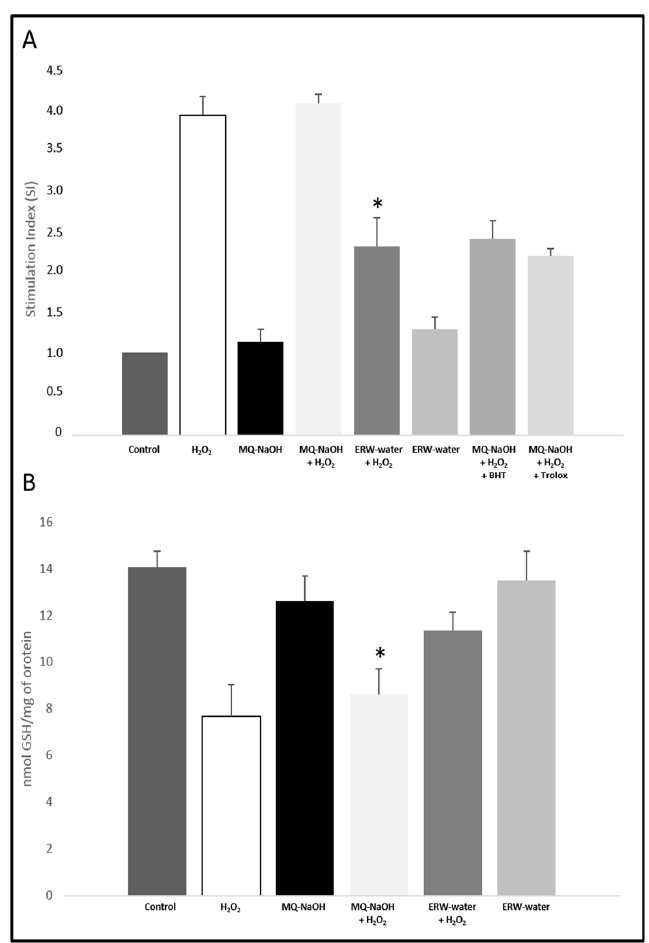
Figure 2. ( A ) Antioxidant activity of ERW water against oxidative stress measured by NBT test. Results were registered as stimulation index (SI). SI value of 1 was assigned to control cells; ( B ) effect of ERW water on GSH levels in U937 cells. * p < 0.05 vs. MQ-NaOH + H 2 O 2 . Data are presented as means ± SD for triplicate experiments.